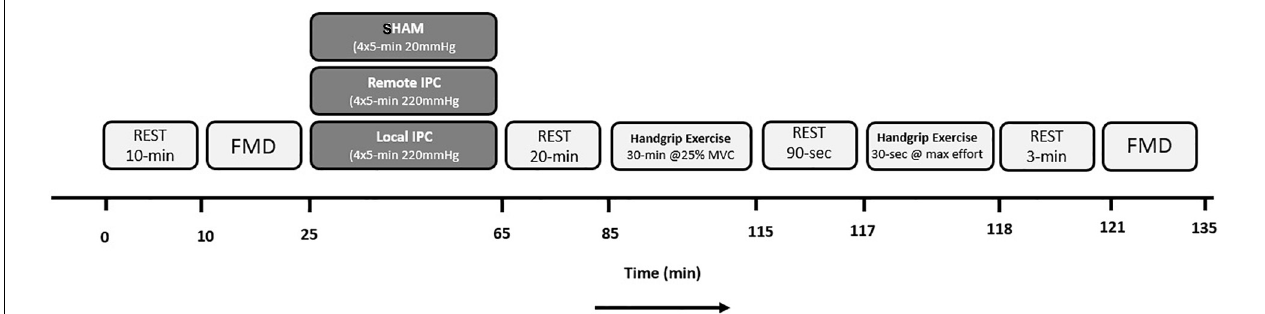
FIGURE 1 | Protocol schematic detailing experimental laboratory